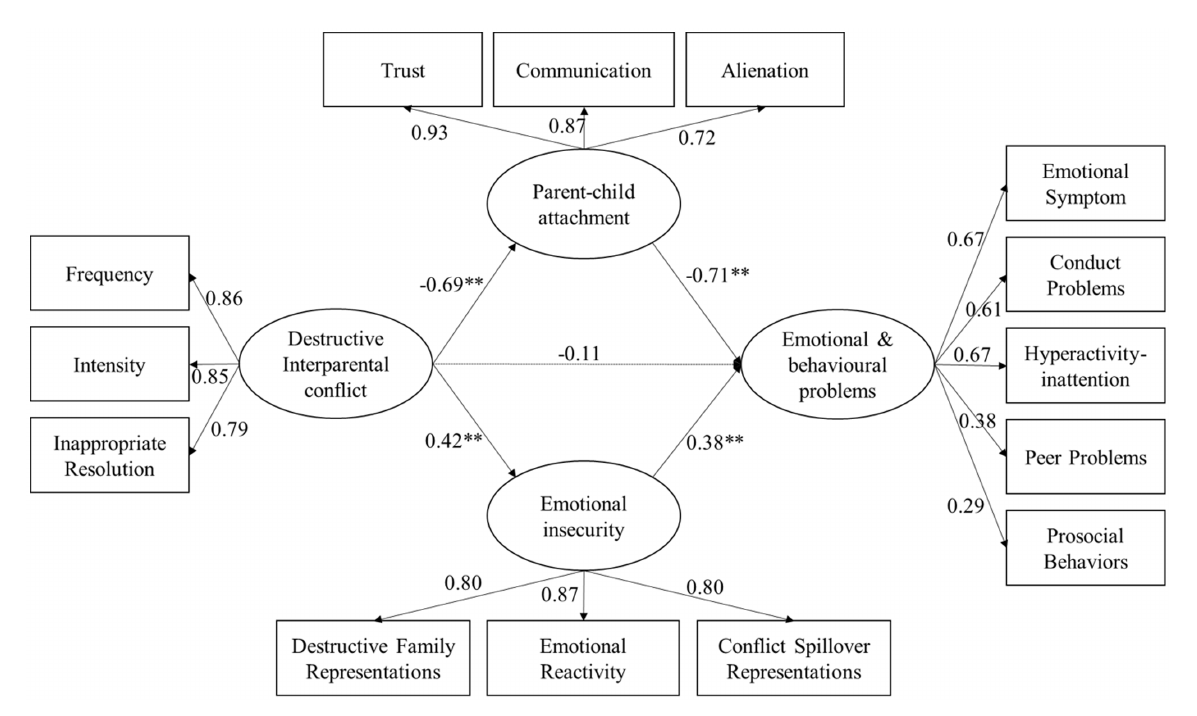
FIGURE 2 Estimates from SEM testing the direct and indirect pathways between destructive IPC and Emotional and behavioural problems. Estimates are standardized coefficients. The dashed line is the nonsignificant path. * p < 0.05; ** p < 0.01. SEM = structural equation